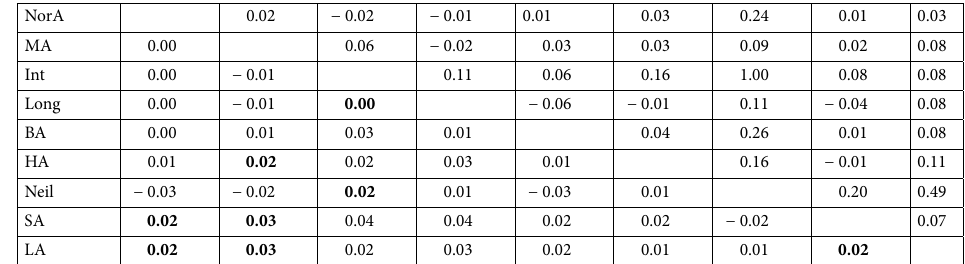
Table 3. Population pairwise F ST calculated using microsatellite and mitochondrial (COI + 16S) data F ST values between populations estimated from the microsatellite data are shown in the lower left half of the table, while G ST values estimated from the mitochondrial DNA are shown on the upper right side. Samples are grouped based on the island of origin and abbreviated as NorA: North Andaman, MA: Middle Andaman, Int: Interview, Long: Long Island, HA: Havelock, BA: Baratang, Neil: Neil Island SA, South Andaman and LA: Little Andaman. Values highlighted in the table correspond to significant divergences after FDR correction (FDR corrected p =